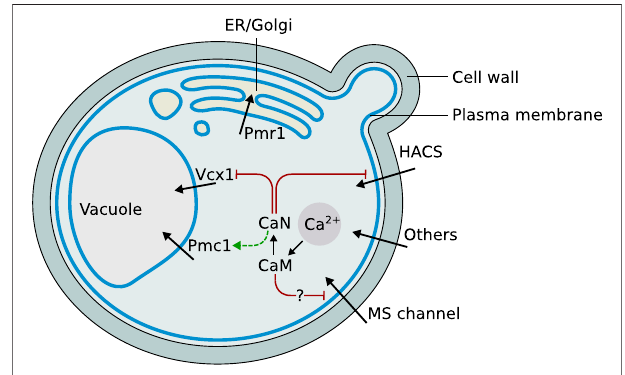
FIGURE 1 | Graphical schematization of the role and localization of the Ca 2+ signaling components included in the model, and their mutual